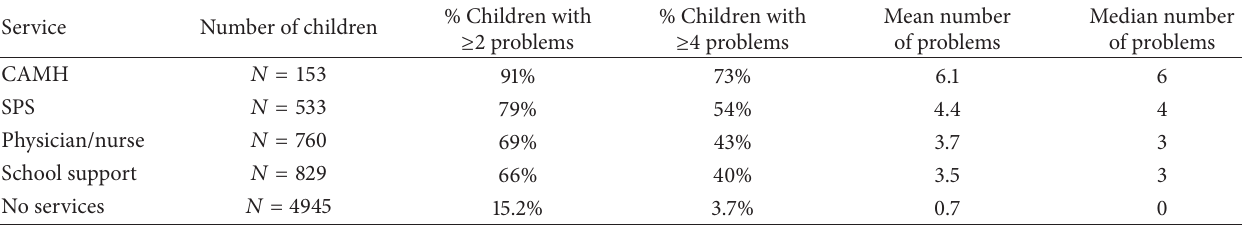
Table 2: Identified children, percent of referred children with ≥ 2 and ≥ 4 problem areas according to parent and/or teacher, mean and median number of problem areas above 95th percentile ( 𝑁 = 6295 ).